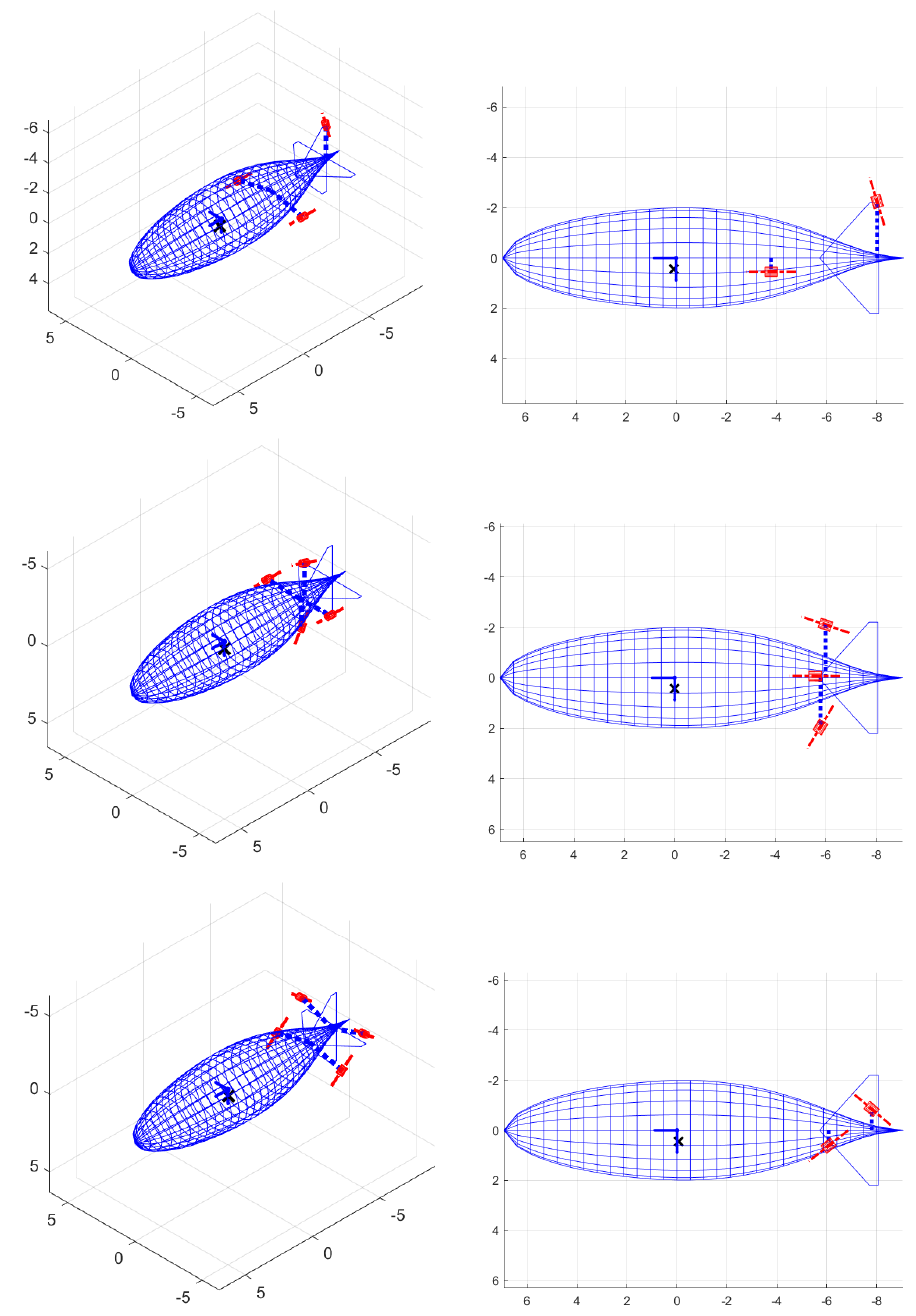
Figure 14. Geometric configuration resulting from global optimization (i.e., over the airspeed spec- trum) on each configuration. Top row : layout (A). Mid row : layout (B). Bottom row : layout (C). Left : three-quarter view. Right : view from the airship left. Length unit: